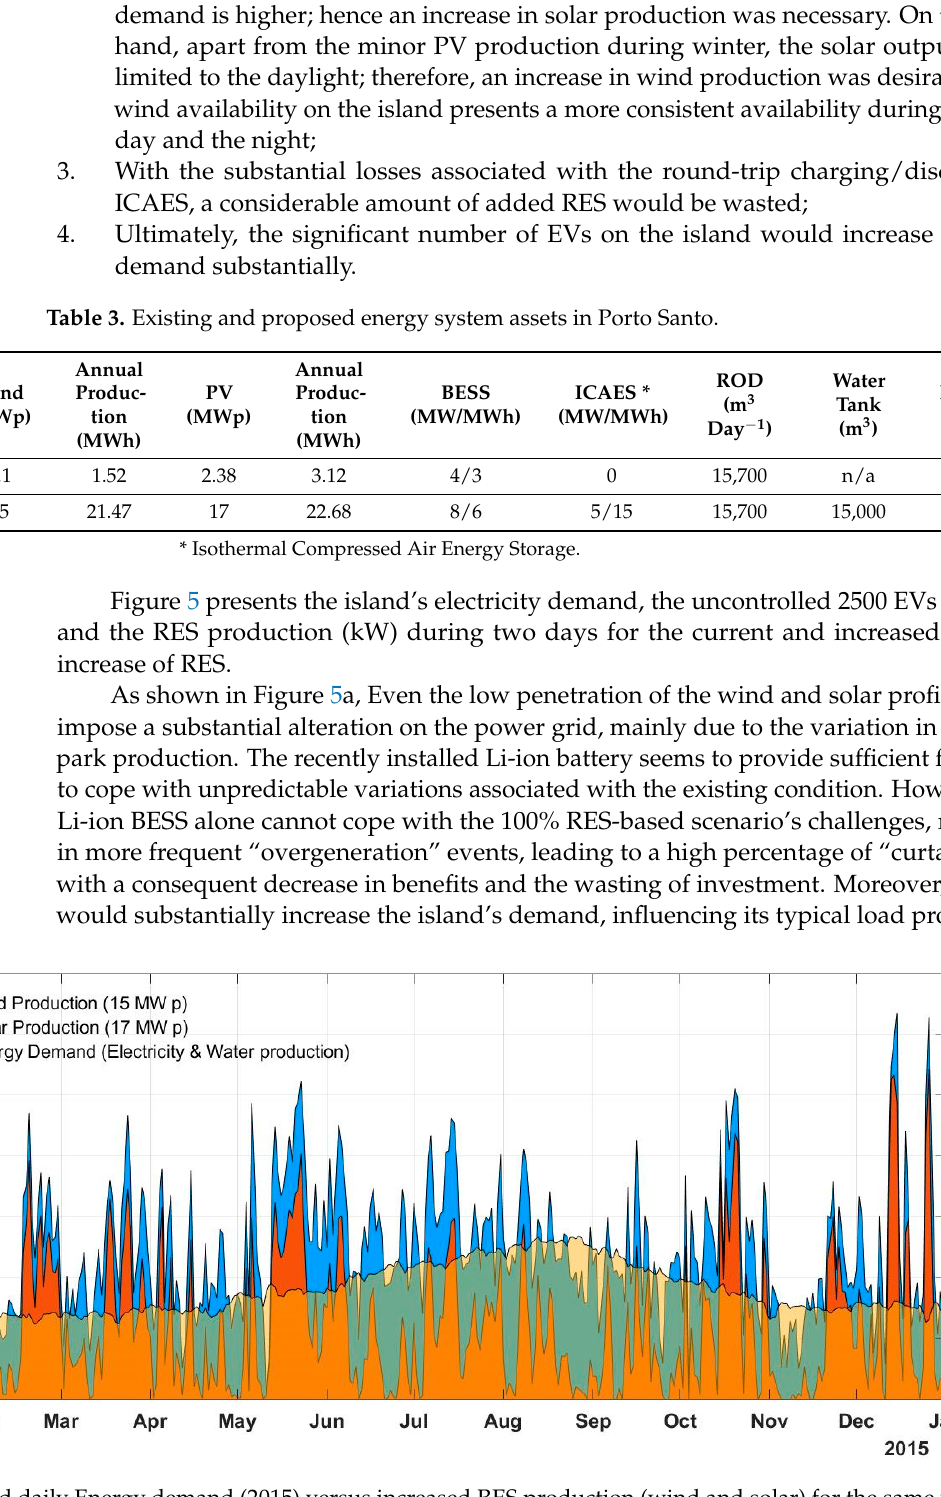
Figure 4. Accumulated daily Energy demand (2015) versus increased RES production (wind and solar) for the same year. Presented data were gathered through communications with the local electricity company (EEM).